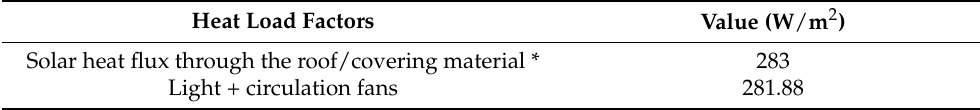
Table 4. Heat load on the greenhouse used for CFD